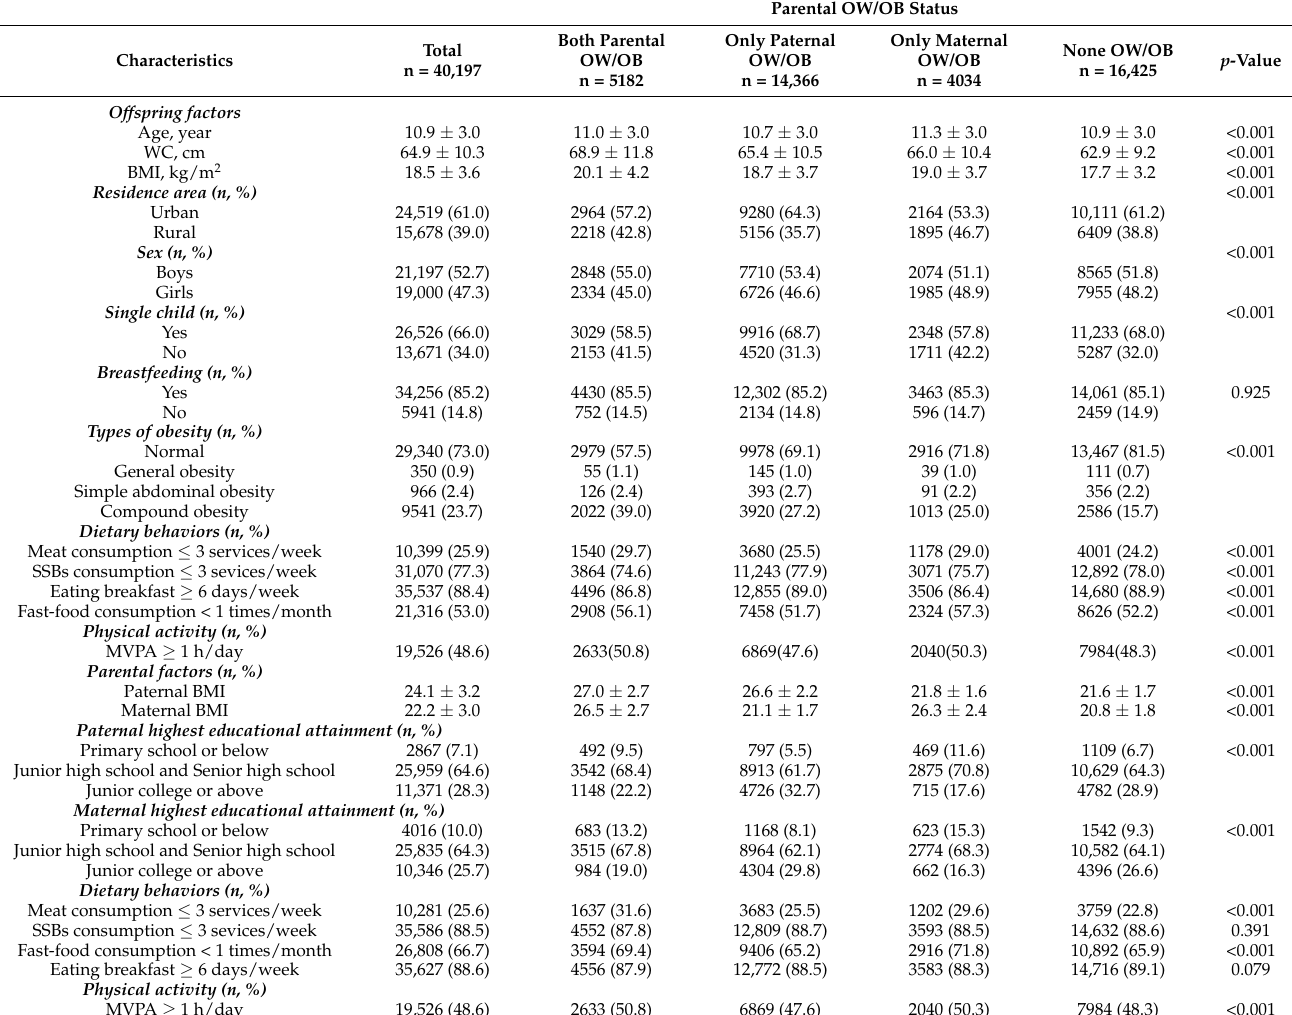
Table 1. Descriptive characteristics of the study population stratified by parental OW/OB